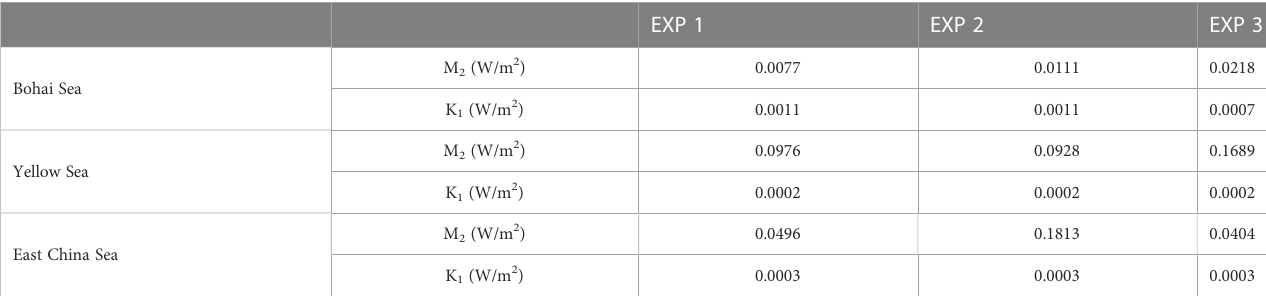
TABLE 4 The estimated bottom friction dissipation in the East China